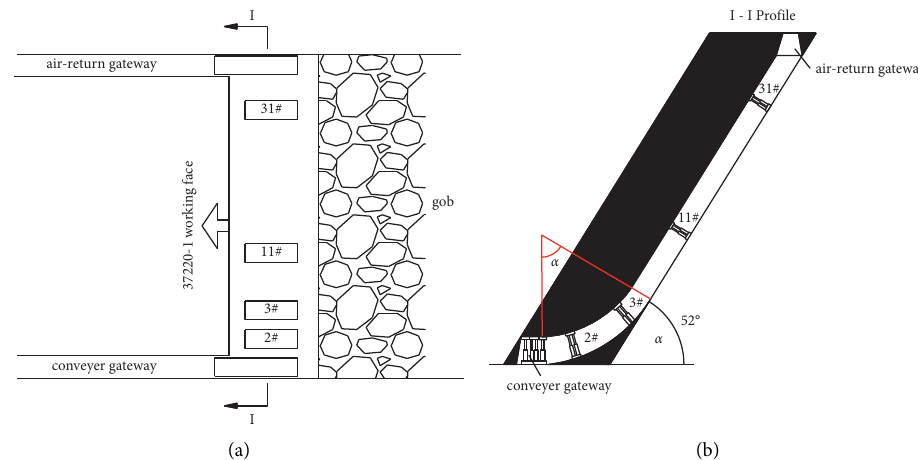
Figure 24: SLL in Dongxia Coalmine, Huating coal field, Gansu province, China [15].